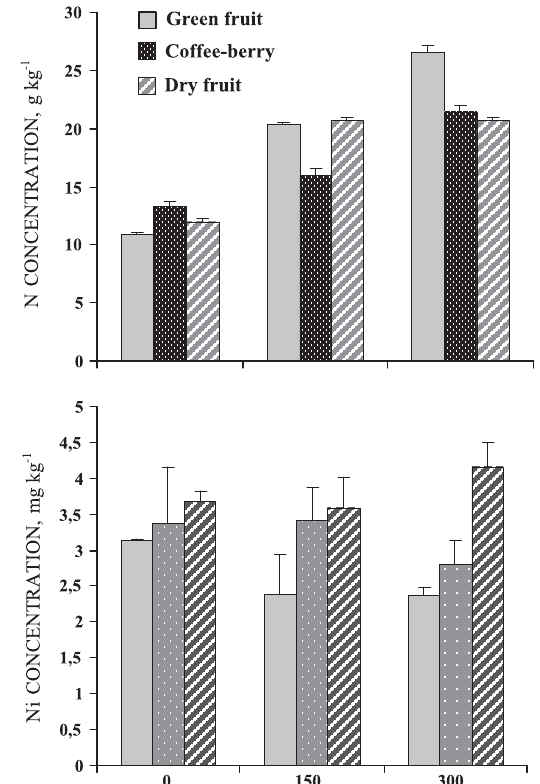
Figure 4. Fruit N and Ni concentrations in different phenological stages, considering different N- rates (control, 150 and 300 kg ha -1 ). Vertical bars indicate mean standard